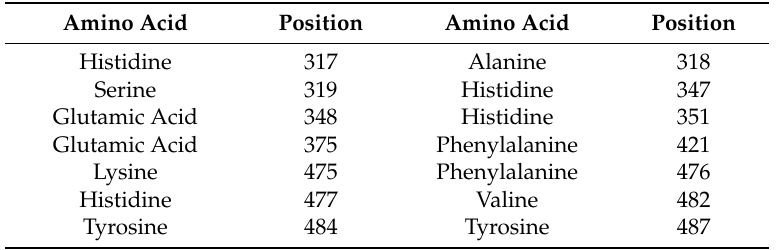
Table 4. Active sites of human